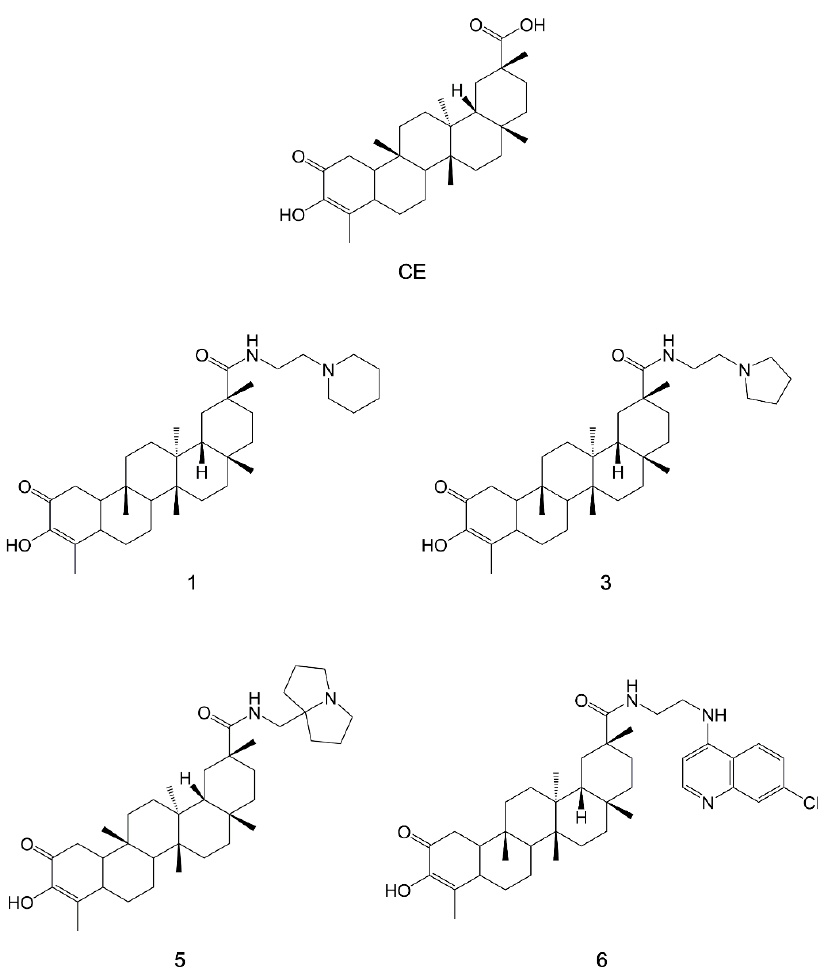
Figure 12. Chemical structures of CE and its carboxamides 1, 3, 5, and 6 [113].